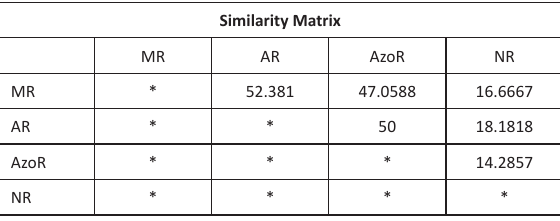
Table 2. Similarity Matrix of distribution of butterfly species in four sacred Similarity Matrix